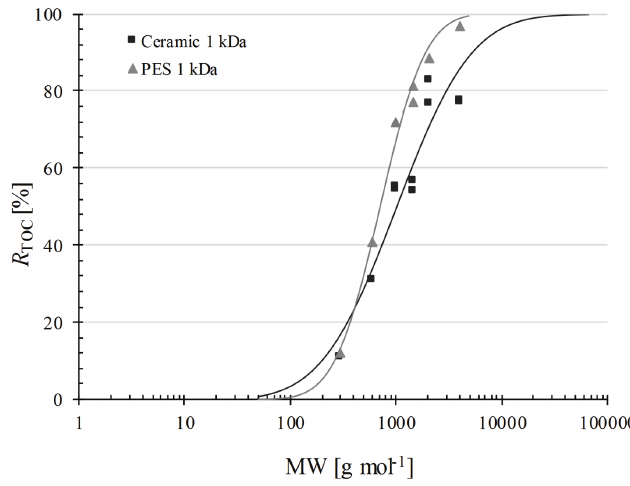
Fig. 2 – Cumulative density distribution function of the poly­ ethylene glycol (PEG) solutions molecular weight (MW) 300 – 4000 g mol –1 for ceramic and polyethersulfone (PES) mem­ brane calculated based on the measured total organic carbon (TOC) rejection efficiency